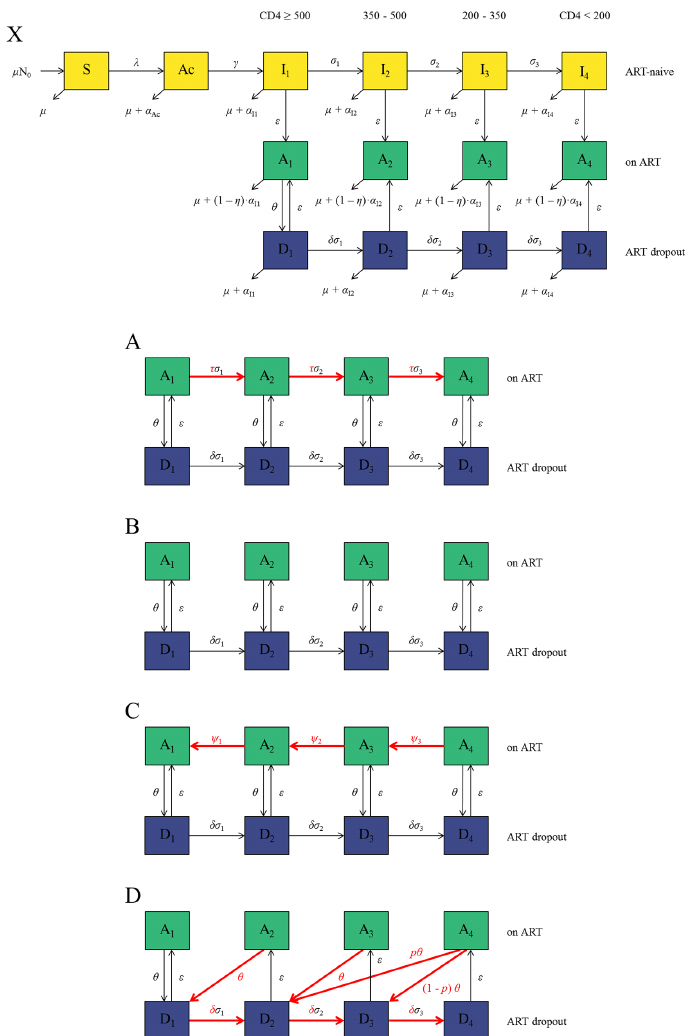
compartments (D i ) and do not show mortality. Key differences are highlighted in red. A) Progression assumption A : ART reduces disease progression rate ( σ i ) by a factor τ while ART dropouts progress at the same rate as ART-naive individuals ( δ = 1). B) Progression assumption B : There is no movement between ART compartments; prognosis depends on CD4 at ART initiation. C) Progression assumption C : ART patients progress to higher CD4 categories over time at a per-capita rate ψ i and the rest is as in progression assumption A. D) Progression assumption D : As in assumption B, there is no movement between ART compartments. However, upon dropping out of ART, individuals move to a higher CD4 category (reflecting improvement in CD4 count on ART) but then progress at an increased rate compared to ART-naive individuals ( δ > 1; reflecting the rapid CD4 decline which occurs after dropping out of